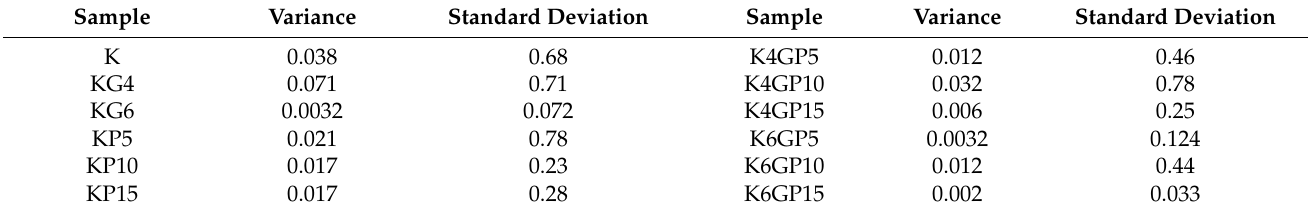
Table 6. Summary of variance and standard deviation of the specimen of shear strength after 28 curing days.